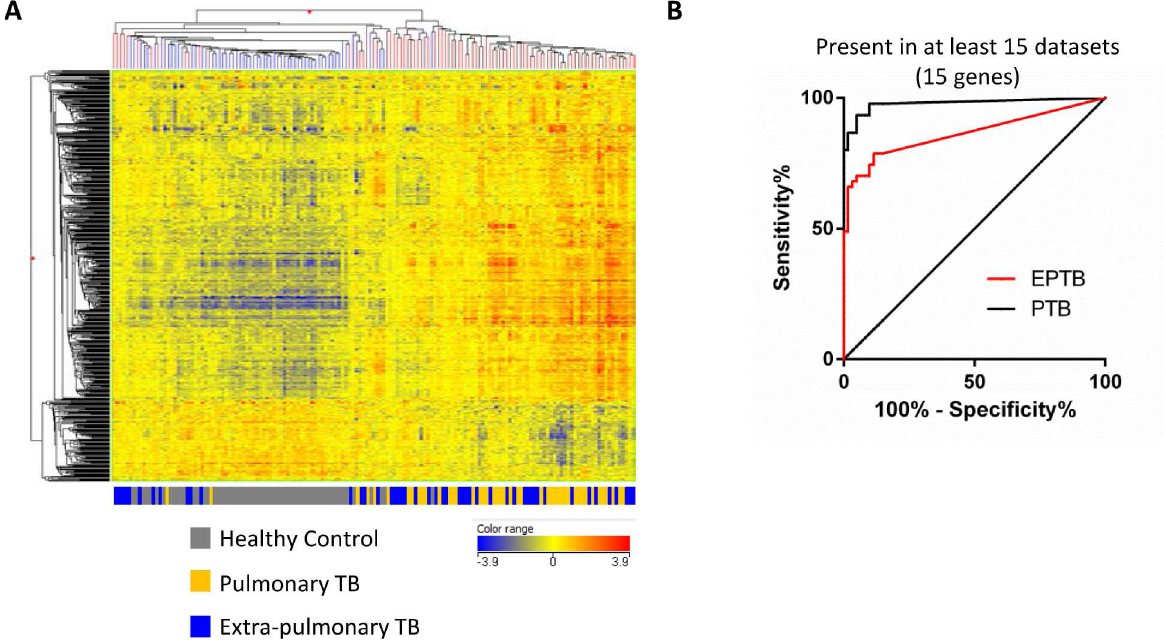
Fig 2. Testing the meta-signature and the most consistently identified genes in a new dataset. (A) The 380 gene meta- signature were mapped to 687 Illumina transcripts, of which 113 transcripts were excludedas they were not significantly detected from backgroundin 10% of samples. Hierarchical clustering (Pearson uncentred (cosine) with averaged linkage) on individualsand transcripts broadly cluster healthy controls from pulmonaryand extra-pulmonary TB patients. (B) Receiver operator curves for extra- pulmonary and pulmonary cohorts against healthy controls using MDTH derived from the most consistently identifiedgenes (15 genes identifiedin at least 15 of the meta-analysis datasets [18]–representing the most robustly identifiedgenes in that analysis, healthy controls used as control group for MDTH) as potential diagnostic biomarker. Both predictionresults were validatedusing k-fold cross validationwith k equal to 10 with 1,000 iterations. The mean AUC for the EPTB and PTB validationresults are 0.865 (95% confidence interval: 0.857–0.872) and 0.977 (95% confidence interval: 0.974–0.981)